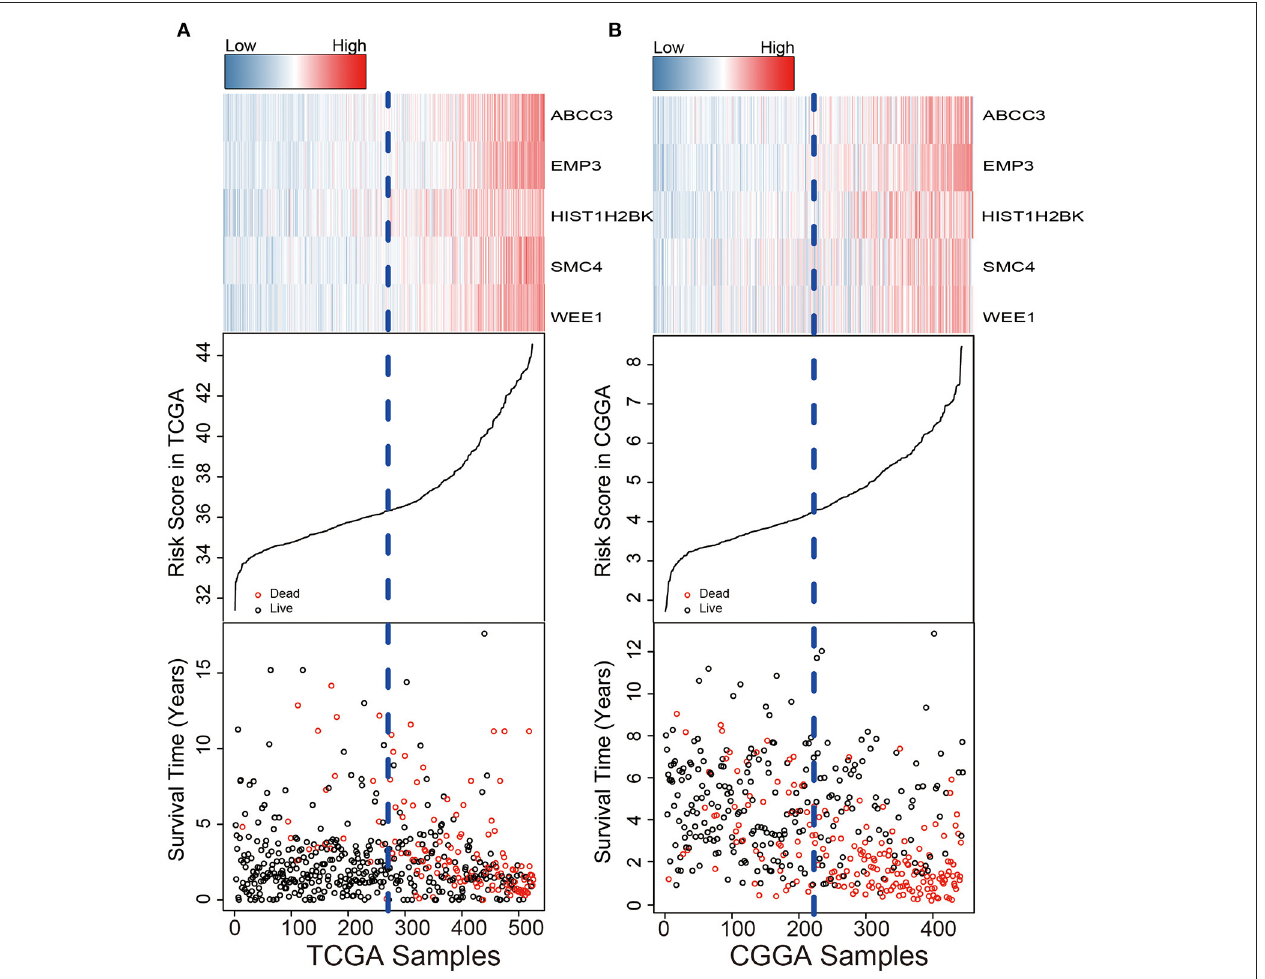
FIGURE 3 | Risk score distribution, survival status, and PCG expression patterns for LGG patients in the training (A) and test (B) datasets.